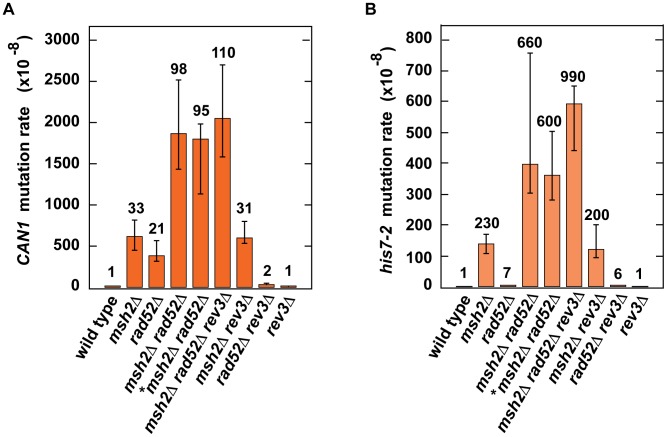
Effect of combining msh2Δ with rad52Δ on spontaneous mutagenesis.Spontaneous CAN1 (A) and his7-2 (B) mutation rates in the indicated strains are shown. The data are presented as medians with 95% confidence intervals. The relative mutation rates are above the corresponding bars. *, the strain was obtained by tetrad dissection.